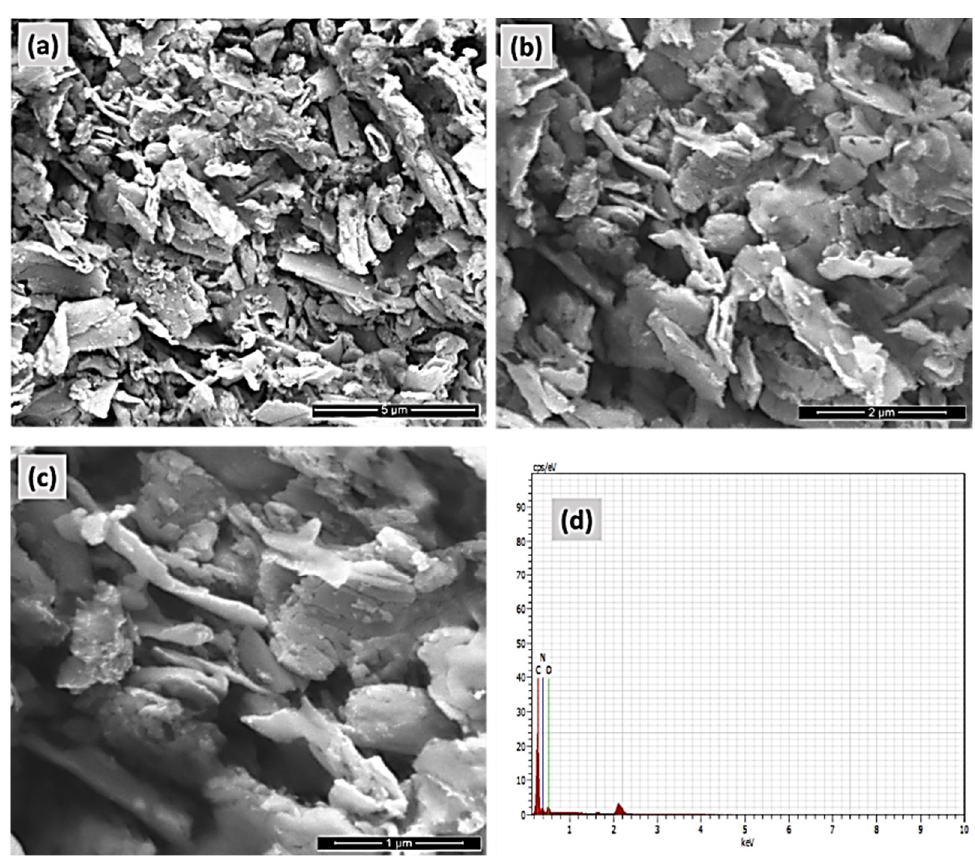
Figure 6. FE-SEM micrograph pictures of ( a – c ) covalent organic polymer (COP-N), and ( d ) EDAX elemental analysis of COP-N.